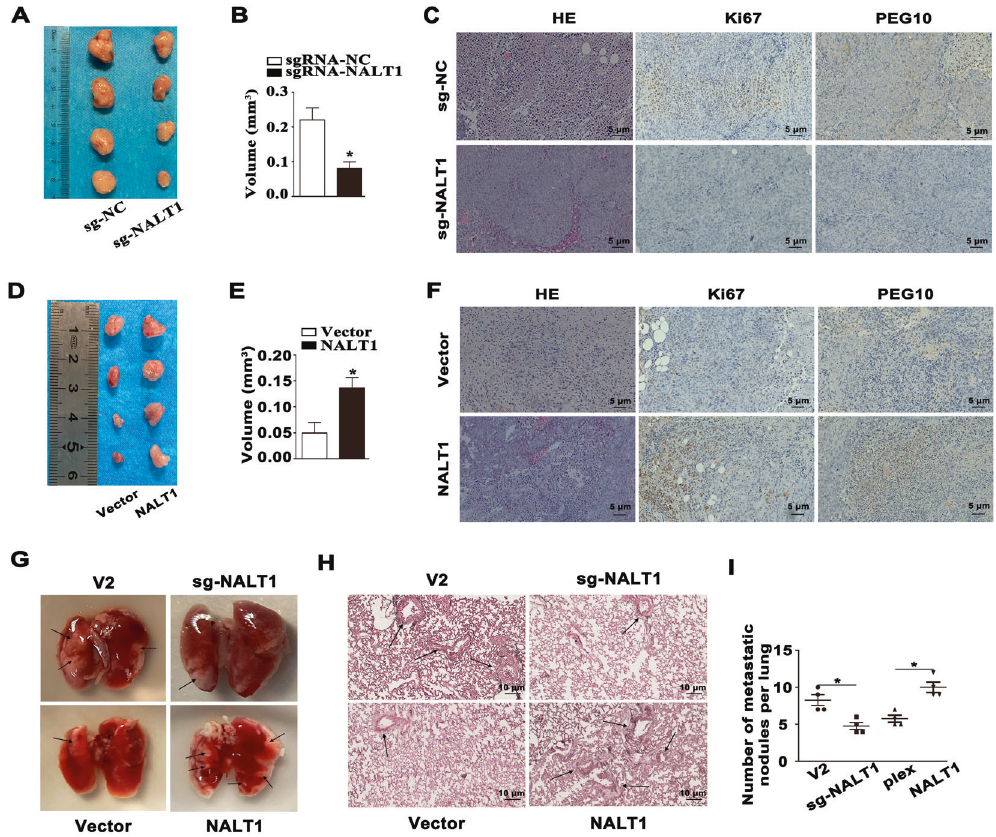
Fig. 7 In vivo examination of the impact of NALT1 on cell growth and metastasis capability. A Representative images of the tumors after subcutaneous injection with NALT1-knockdown and NC HCT116 cells. B Tumor volume was analyzed in NALT1-knockdown/control group. C Representative images of immuno fl uorescence and H&E staining using antibodies against PEG10 and Ki-67. D Representative images of the tumors after subcutaneous injection with NALT1-overexpression and NC HCT116 cells. E Tumor volume was analyzed in the NALT1- overexpression/control group. F Representative images of immuno fl uorescence and H&E staining using antibodies against PEG10 and Ki-67. G After injection of NALT1-knockdown or overexpression HCT116 cells into the spleen of nude mice at fi ve weeks, the lungs were isolated from the mice and the metastatic lung nodules were marked. H Representative images of lung tissue sections by H&E staining. I The number of metastatic nodules in the